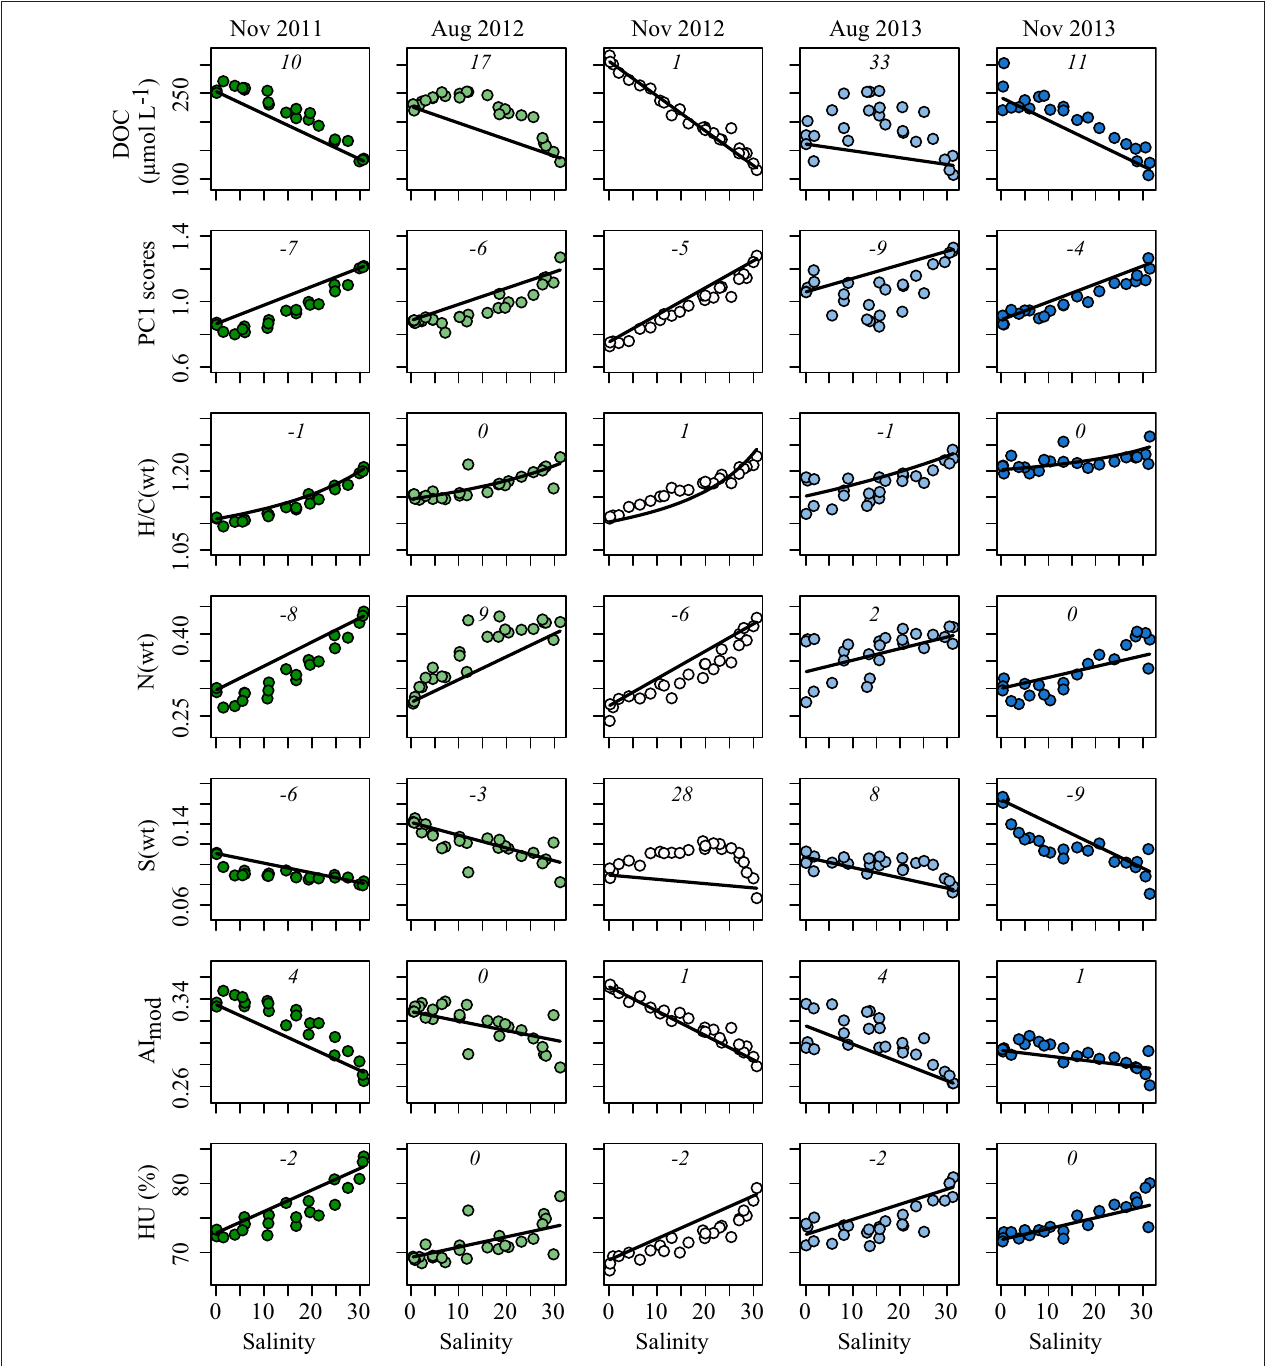
FIGURE 1 | DOC concentration and characteristics of DOM molecular composition (rows) vs. salinity for all five cruises (columns). PC1 scores are from Figure 3 (1 was added to each score for data representation); H/C ratio, N- and S-content of molecular formulae were weighted by peak intensity; AI mod , modified aromaticity index; HU, percentage of highly unsaturated compounds. Solid lines represent conservative mixing lines calculated using averages of the two samples of lowest and highest salinities, respectively. Numbers in italics denote percentage of deviation between the conservative mixing line and the measured values (see section Materials and